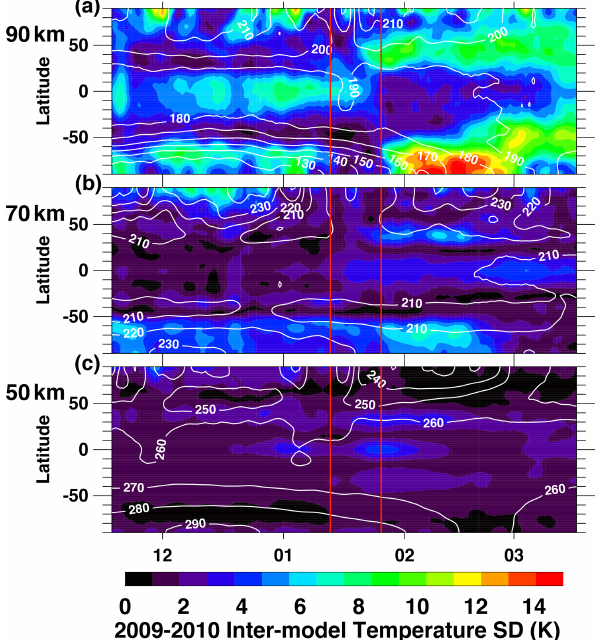
Figure 10. Latitude–time cross-sections from 1 December 2009 to 31 March 2010 of the standard deviation in daily mean zonal mean temperature among the meteorological data sets at 90km (top), 70km (middle), and 50km (bottom). There is no MERRA-2 data at 90km. For reference, white contours indicate the mean values among the data sets. Vertical red lines in each panel denote 27 Jan- uary and 9 February, as described in the text. Month tick labels along the x axes are placed at the 15th of each month.